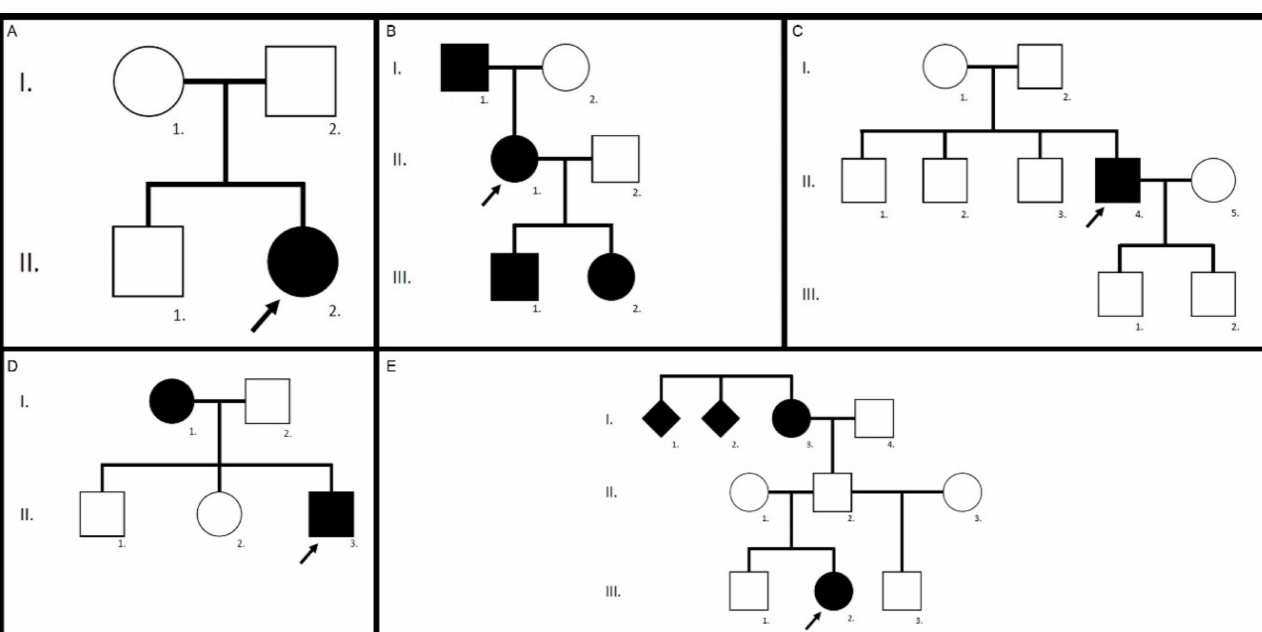
Figure 5. Family trees of the ELOVL4 cohort. Family 12, patient II.2 ( A ), family 13, patients I.1, II.1, III.1 and III.2 ( B ), family 14, patient II.4 ( C ), family 15, patient II.3 ( D ), and family 16, patient III.2 ( E ).